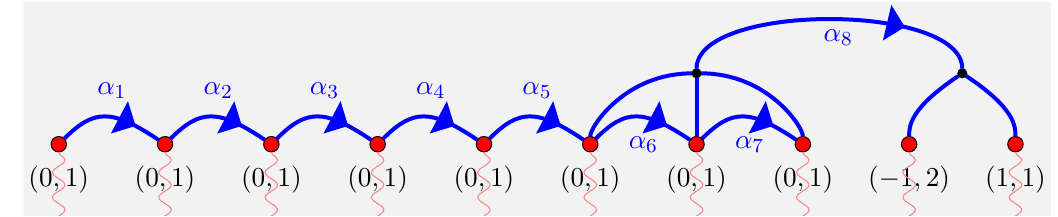
Figure 2 . A presentation of the singularities on the Coulomb branch of the maximally deformed II (cid:3) singularity, with the singularities and their cuts in red, labelled by their EM charge vectors. In blue is a basis found in [19] of eight neutral oriented \string webs" connecting the singularities corresponding to simple roots of E 8